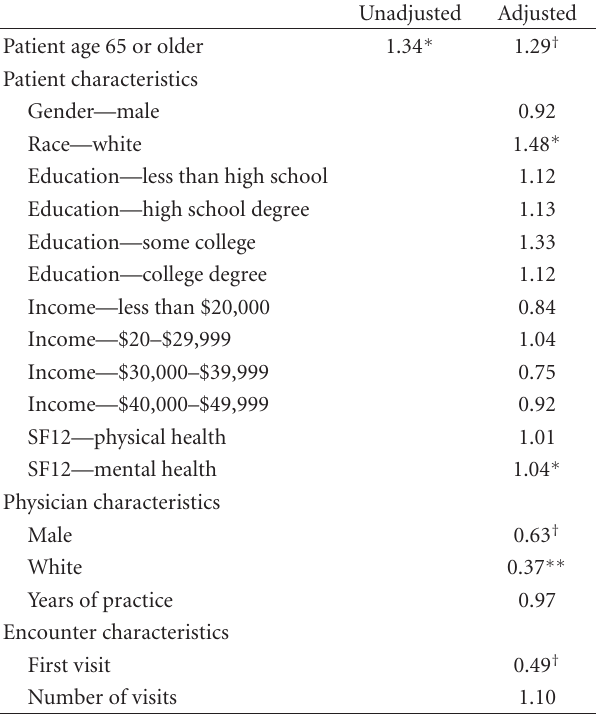
Table 7: Odds ratios from binary logistic regression predicting pa- tient